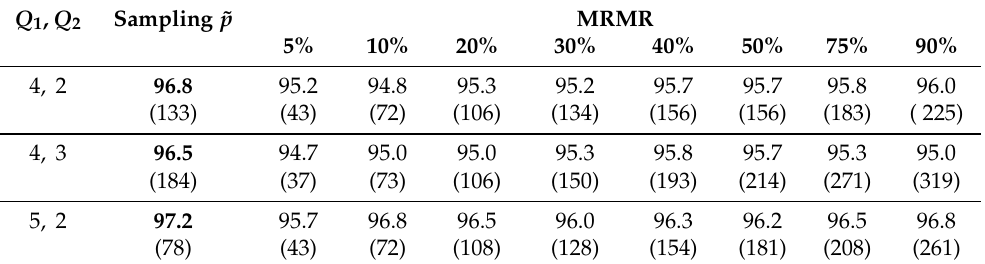
Table 3. FSDD Dataset; 1st col: WST Q factors; 2nd col: Classification accuracy (%) for the optimal sampling step; Cols 3–10: MRMR ranking-based feature selection: classification accuracy (%) by